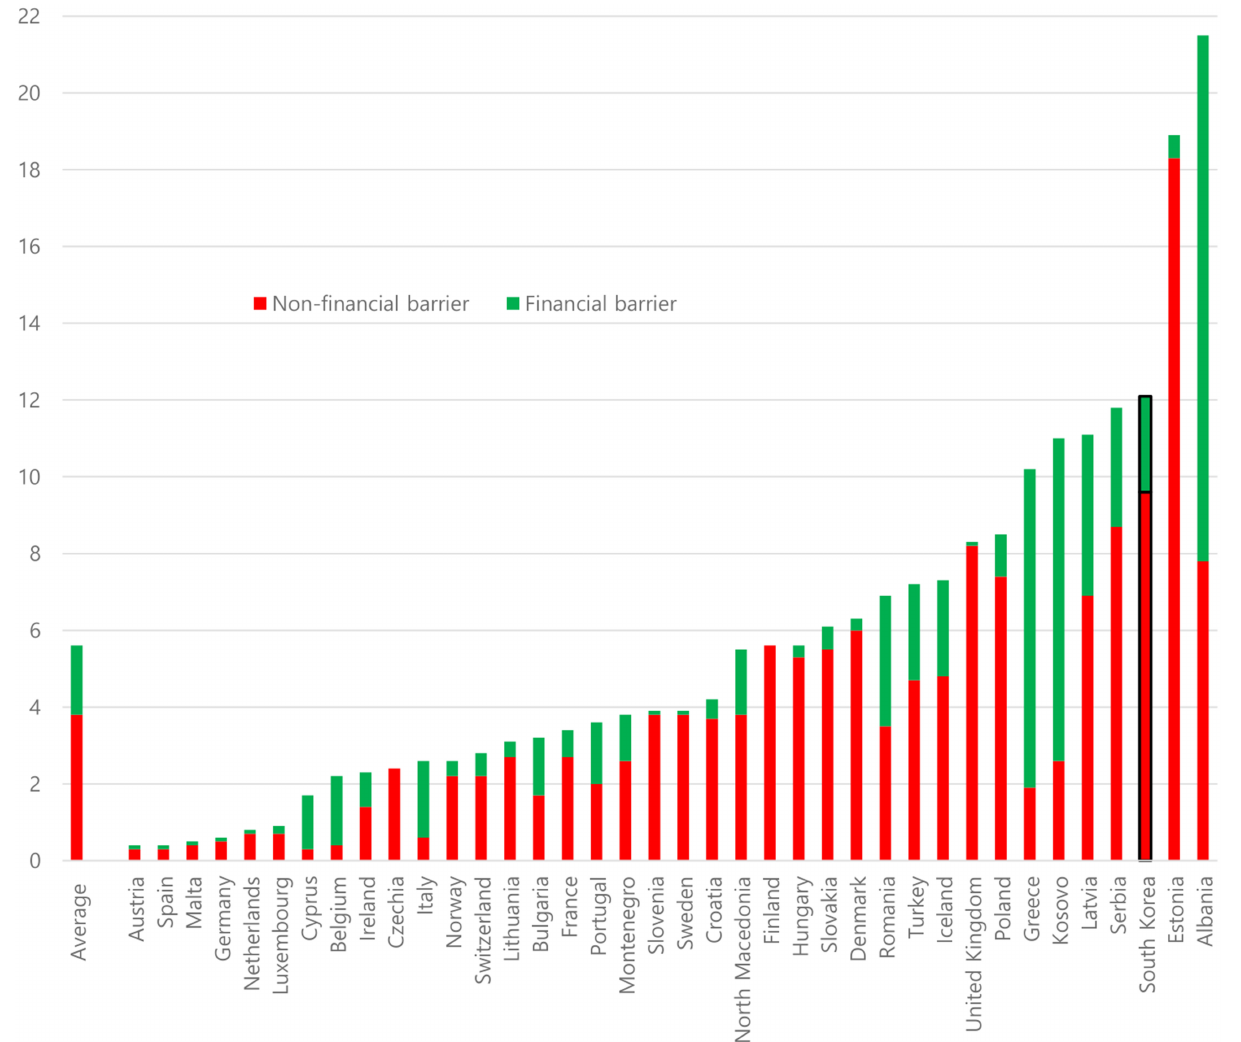
FIGURE 1 | Percentage of people experiencing either non-financial or financial barriers in 2018 across selected countries. Unmet needs for medical examination or treatment for multiple reasons in the previous 12 months. Individuals included those aged 16 years and above (37 European countries) and individuals aged 19 years and above (South Korea). Sources: EUROSTAT Database (EU-SILC, 2018) and the Korea Health Panel survey data